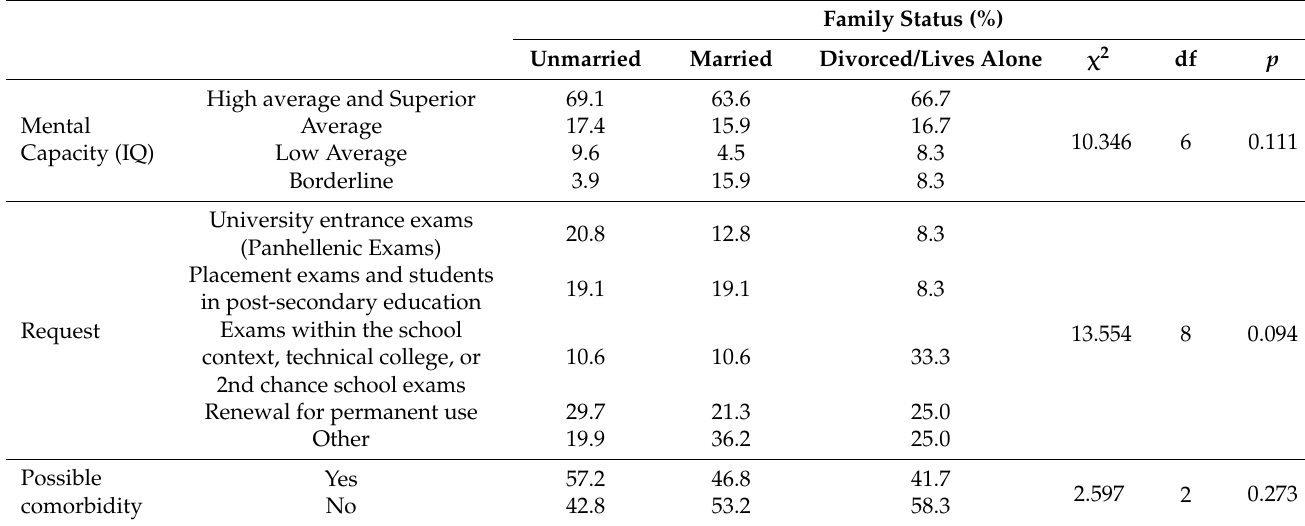
Table A13. Relationship of the Family status of the assessed adults with the other